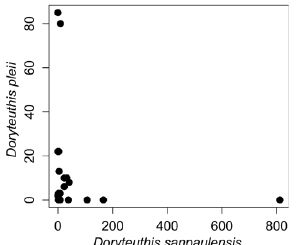
Figure 13. Catches of Doryteuthis sanpaulensis and D. pleii within the shared area.